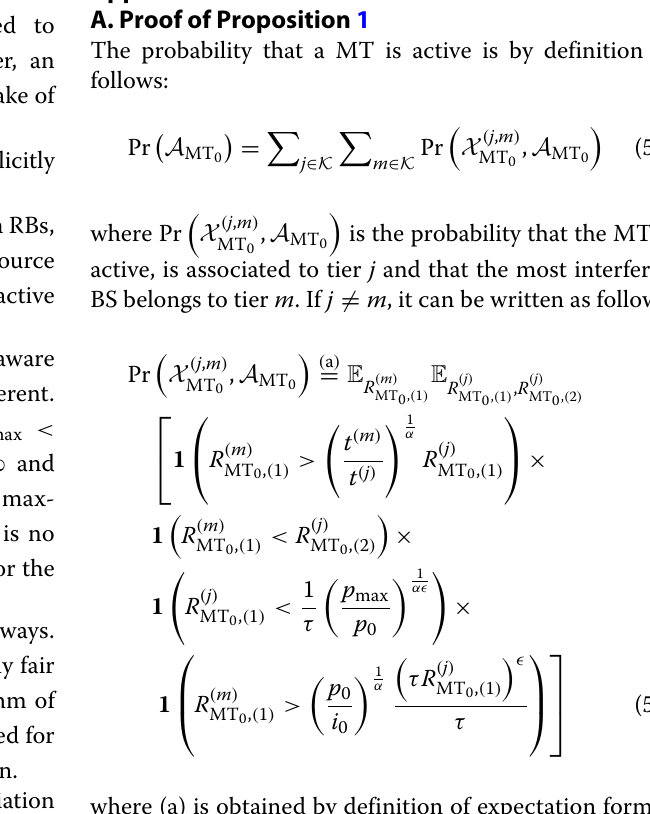
Endnotes 1 The proposed framework can be generalized